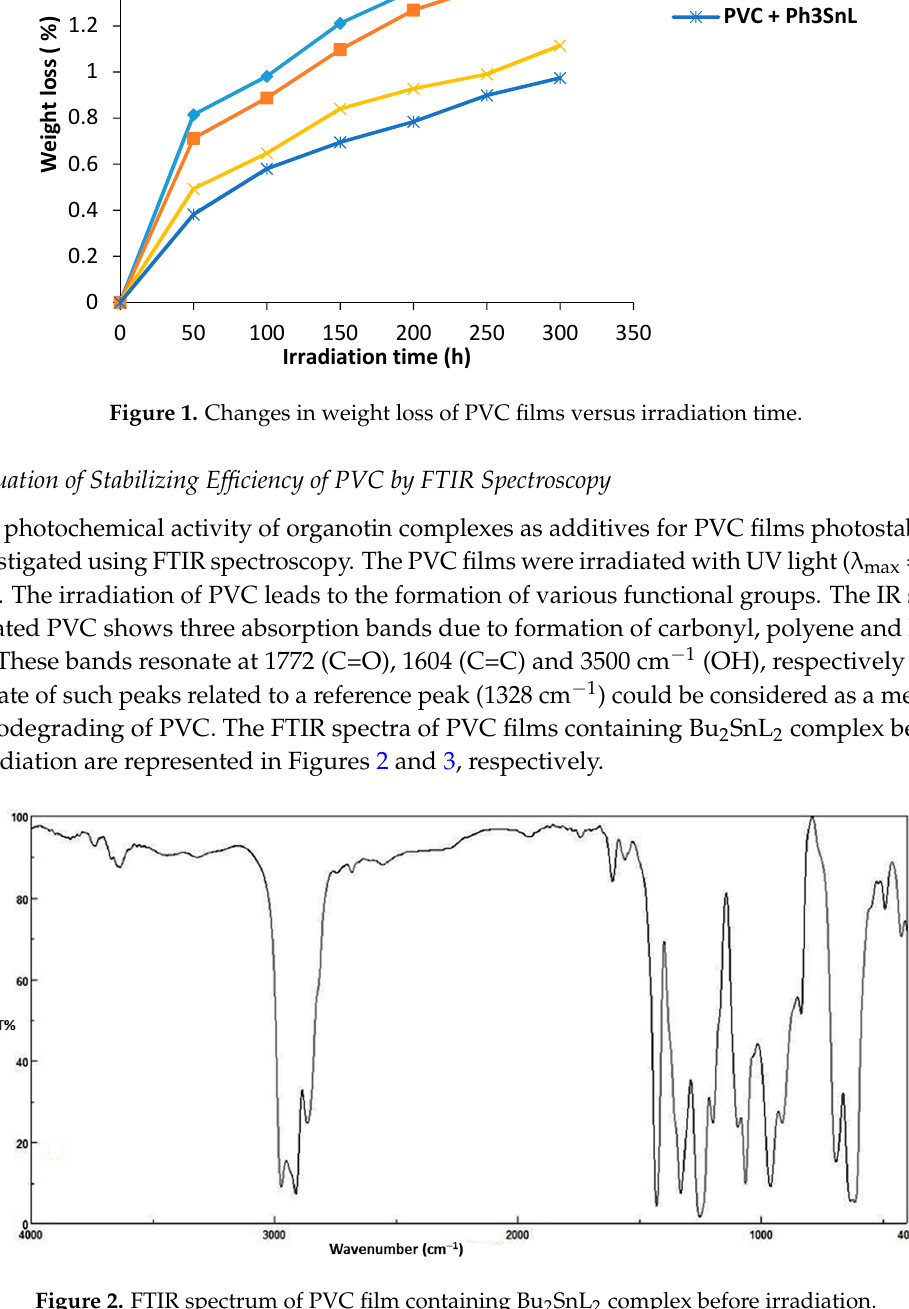
Figure 3. FTIR spectrum of PVC film containing Bu 2 SnL 2 complex after irradiation. Figure 4. Changes in the I C=O index for PVC films versus irradiation time. 00.10.20.30.40.5 0